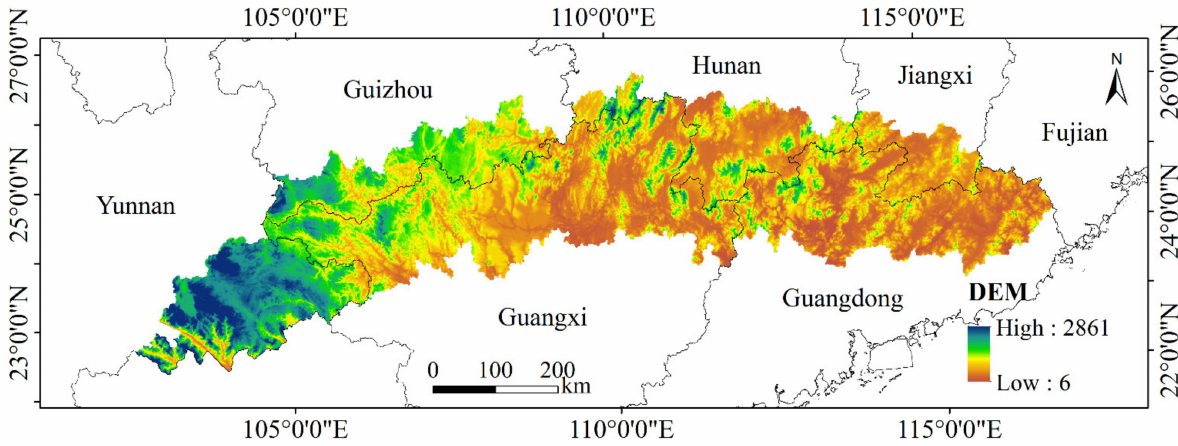
Figure 1. Location and LULC of the southern hill and mountain belt (Guangdong, Guangxi, Jiangxi, Hunan, Guizhou and Yunnan Provinces,